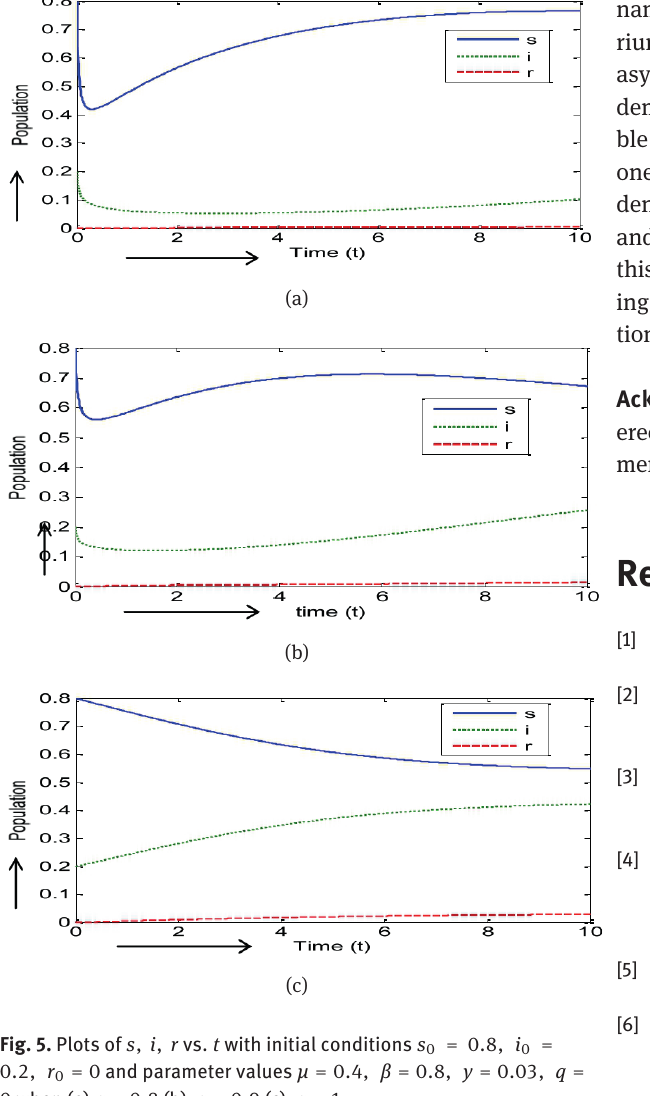
Fig. 5. Plots of s , i , r vs. t with initial conditions s 0 = 0.8, i 0 = 0.2, r 0 = 0 and parameter values μ = 0.4, β = 0.8, γ = 0.03, q = 0 when (a) α = 0.8 (b) α = 0.9 (c) α =